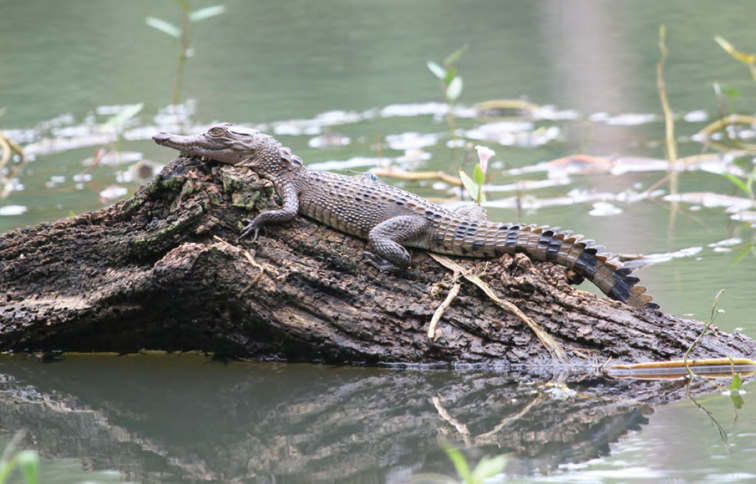
Crocodylus mindorensis basking on a log in the Dunoy Lake, Barangay Dibuluan (Location 24): Photo MVW.